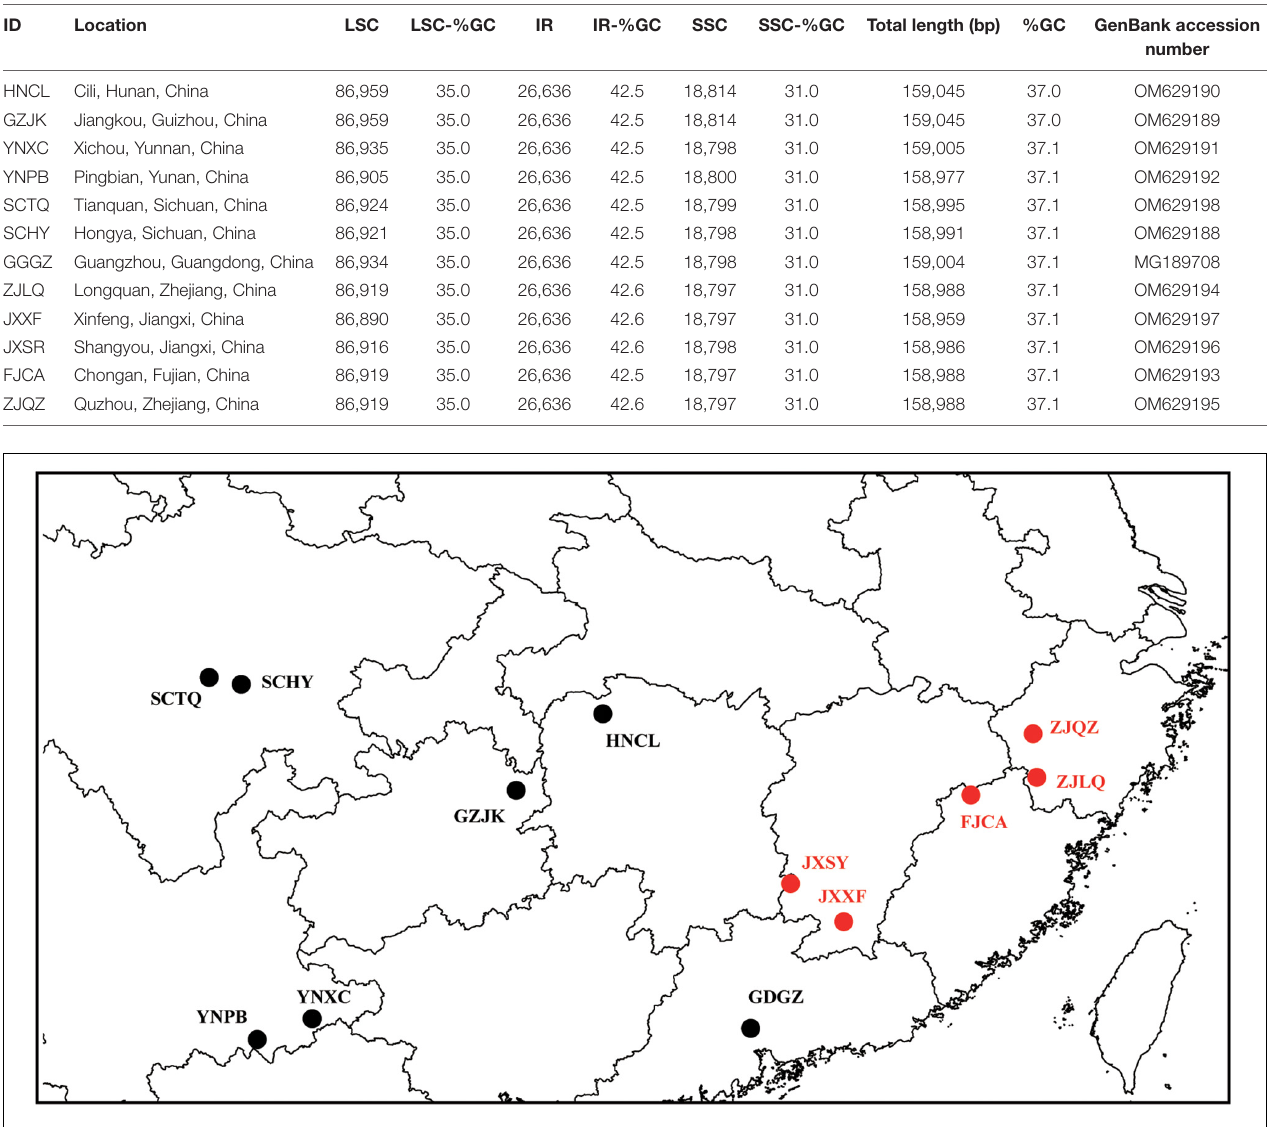
FIGURE 1 | Sampling locations of the B. sinensis individuals investigated.